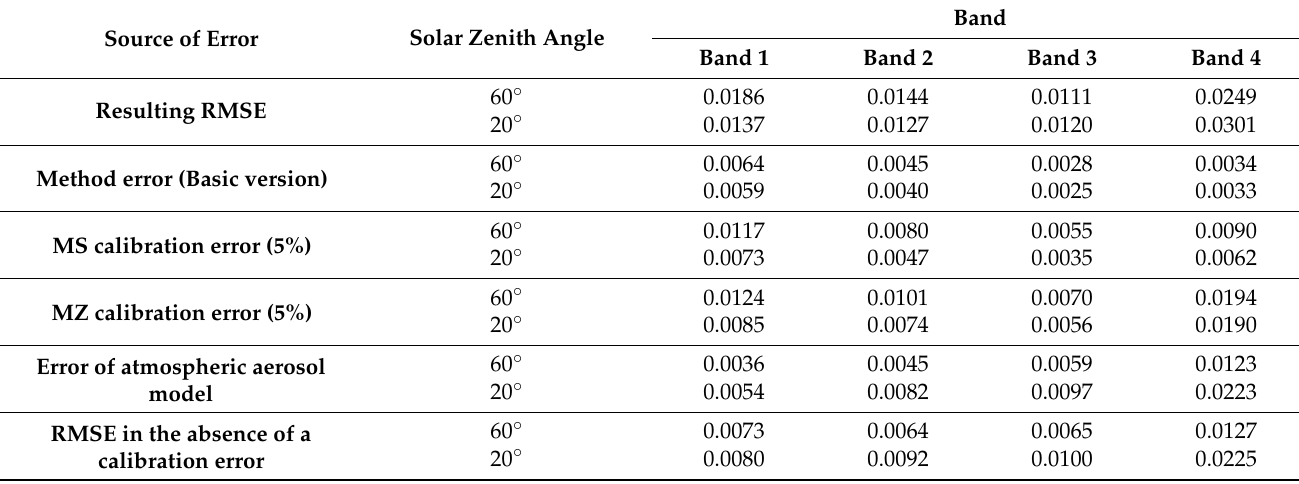
Table 12. Resulting RMSE of surface reflectance retrieval in the MZ channels and the contribution of various sources of error. Case with a dark underlying surface.